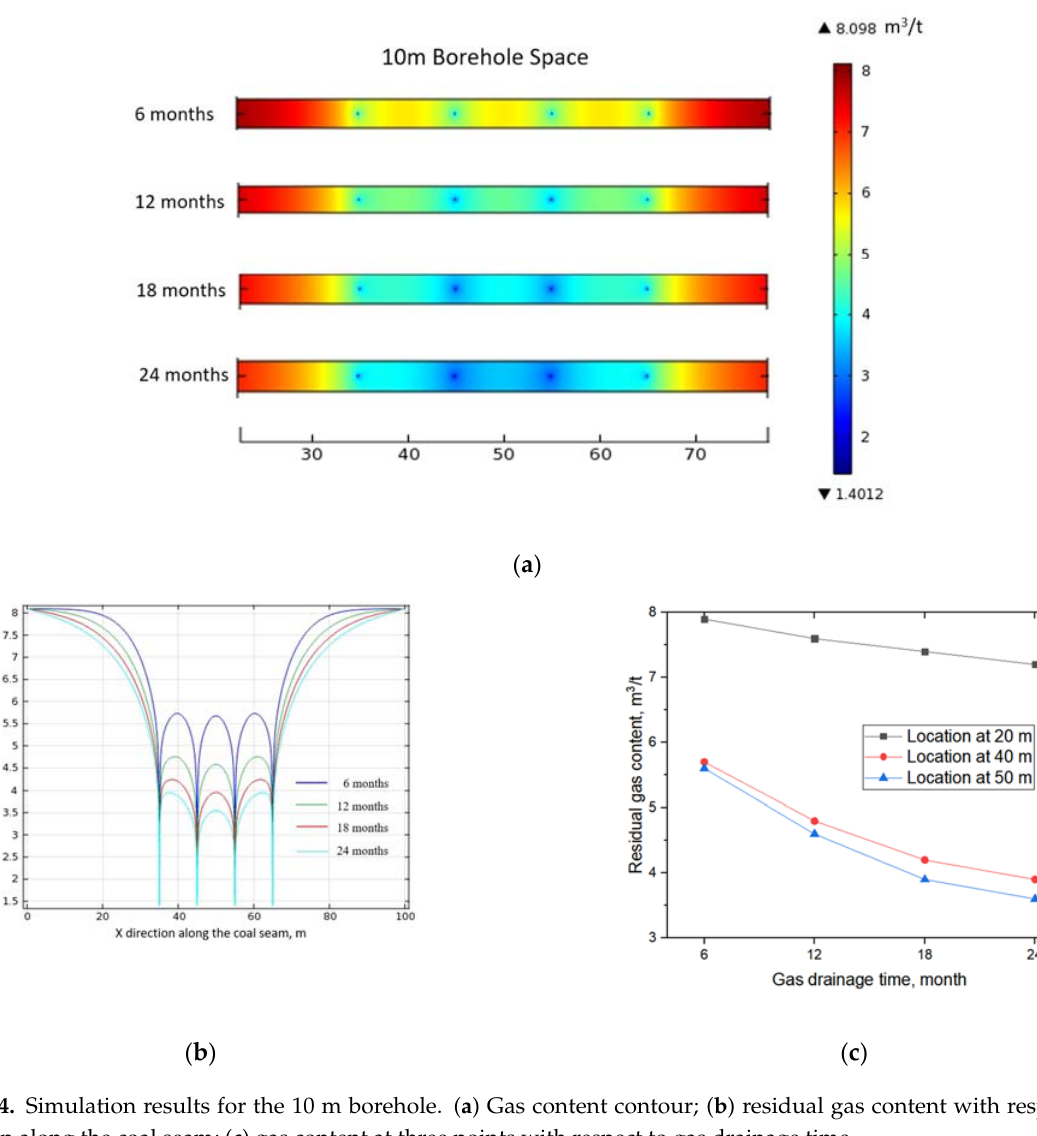
* √ : the gas drainage results meet the threshold limit value; ×: the gas drainage results do not meet the threshold limit value.